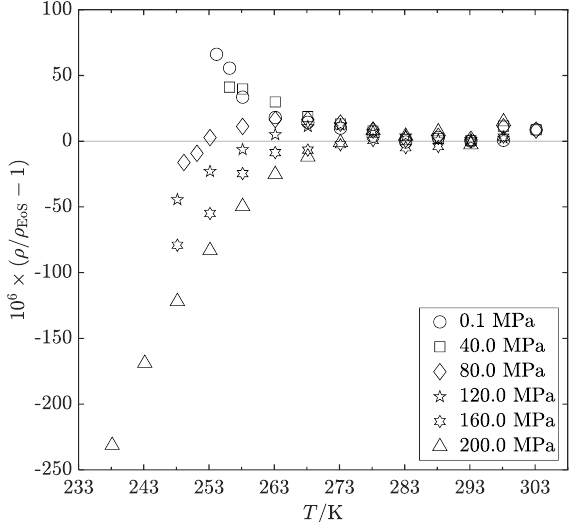
Fig. 8. Relative deviations of seawater densities from this work from densities calculated with TEOS-10 equation [15,